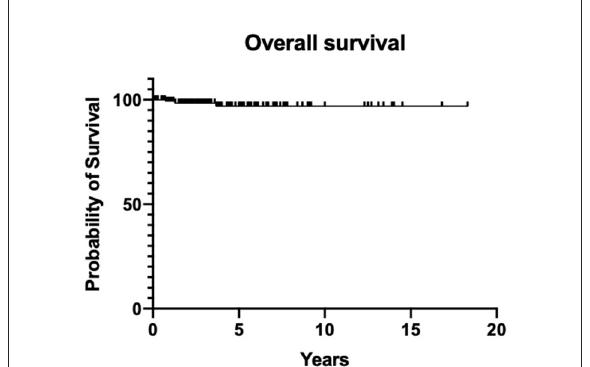
FIGURE1 Overall survival (OS) of the study population.